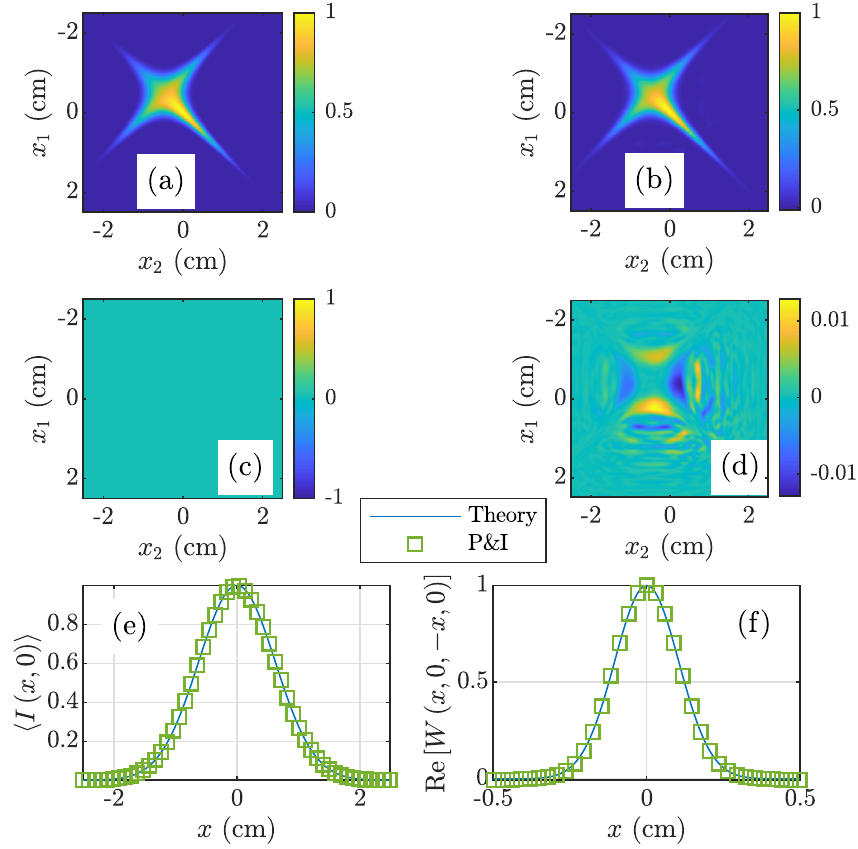
Figure 5. NUC beam CSD function results—( a ) theory and ( b ) P&I Re [ W ( x 1 ,0, x 2 ,0 )] ; ( c ) theory and ( d ) P&I Im [ W ( x 1 ,0, x 2 ,0 )] ; ( e ) theory and P&I (cid:104) I ( x ,0 ) (cid:105) ; and ( f ) theory and P&I Re [ W ( x ,0, − x ,0 )] . The P&I field expression is given in Equation (2). The theoretical CSD function is given in Equation